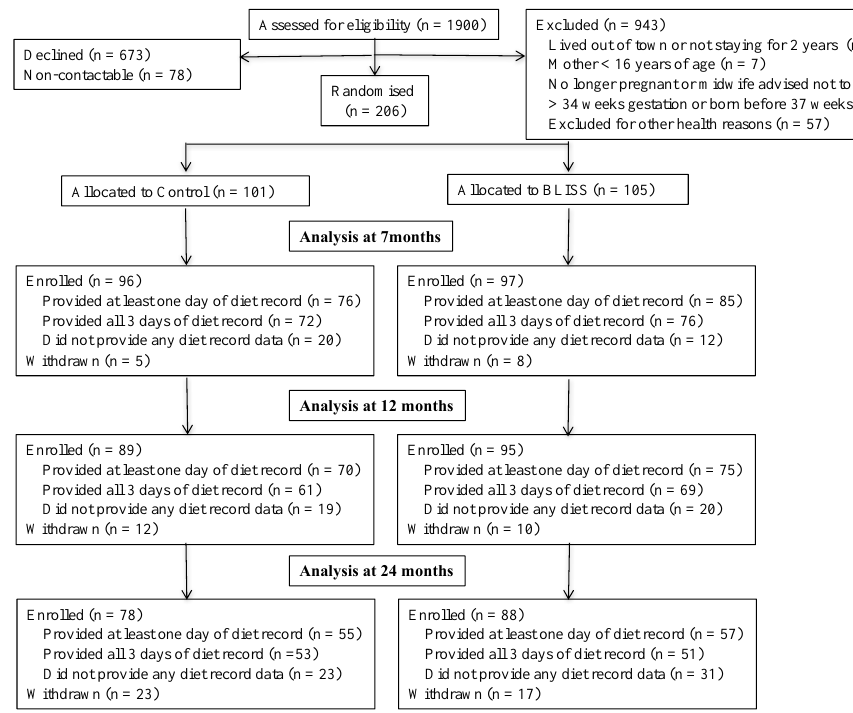
Figure 1. Flow of participants through the study.